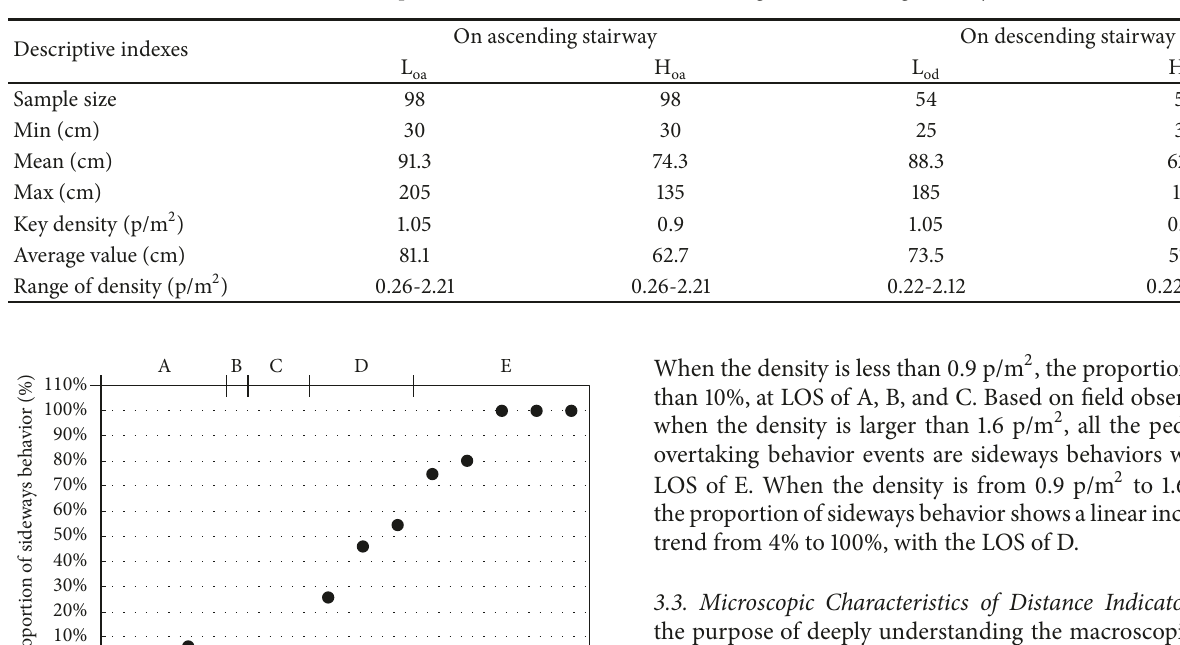
Table 3: Description of distance indicators on ascending and descending stairways.